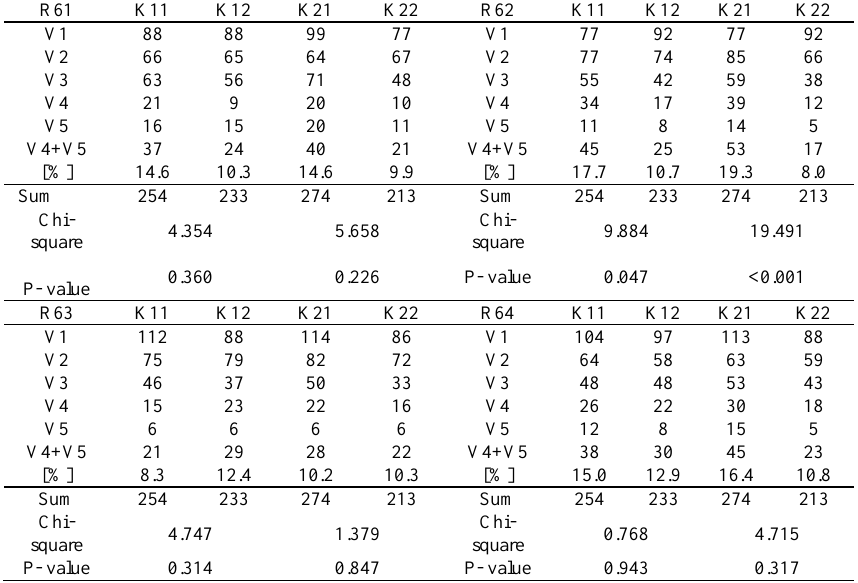
Table 6. The evaluation of sources of safety risk by entrepreneurs